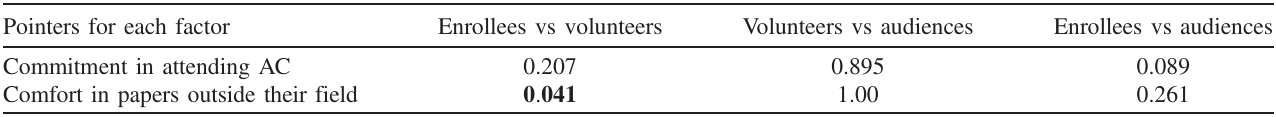
Bold indicates significant results ( p ≤ 0 . 05 ). TABLE VI. Two-tailed Fisher exact test p values corresponding to the data in Fig. 3. Compared groups